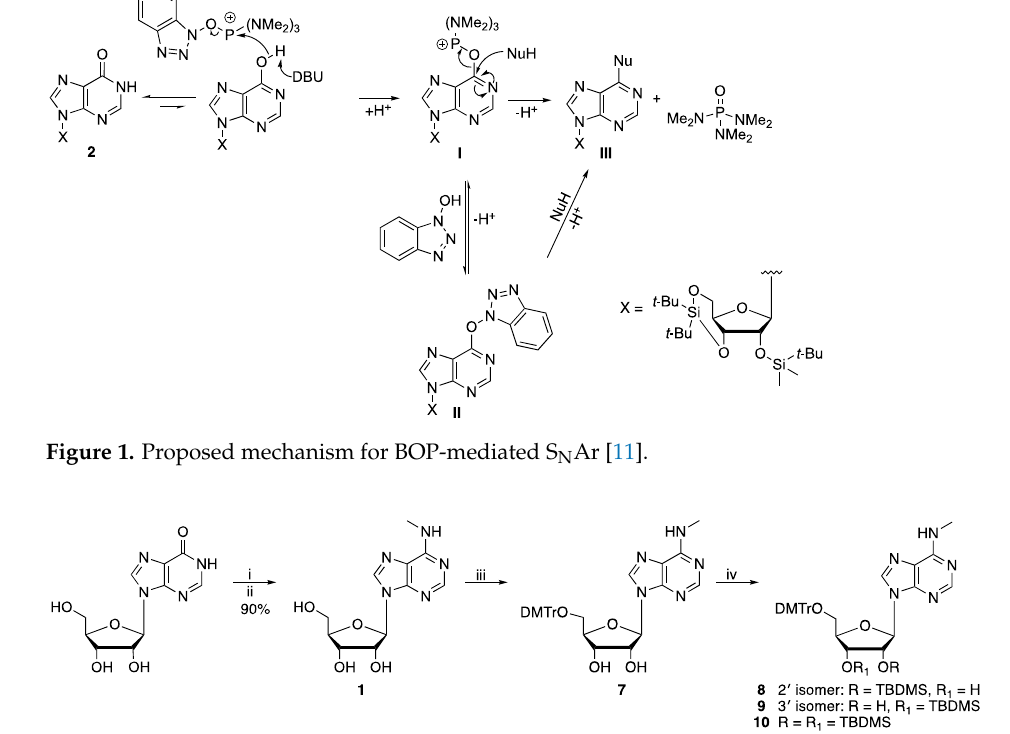
Figure 1. Proposed mechanism for BOP-mediated S N Ar